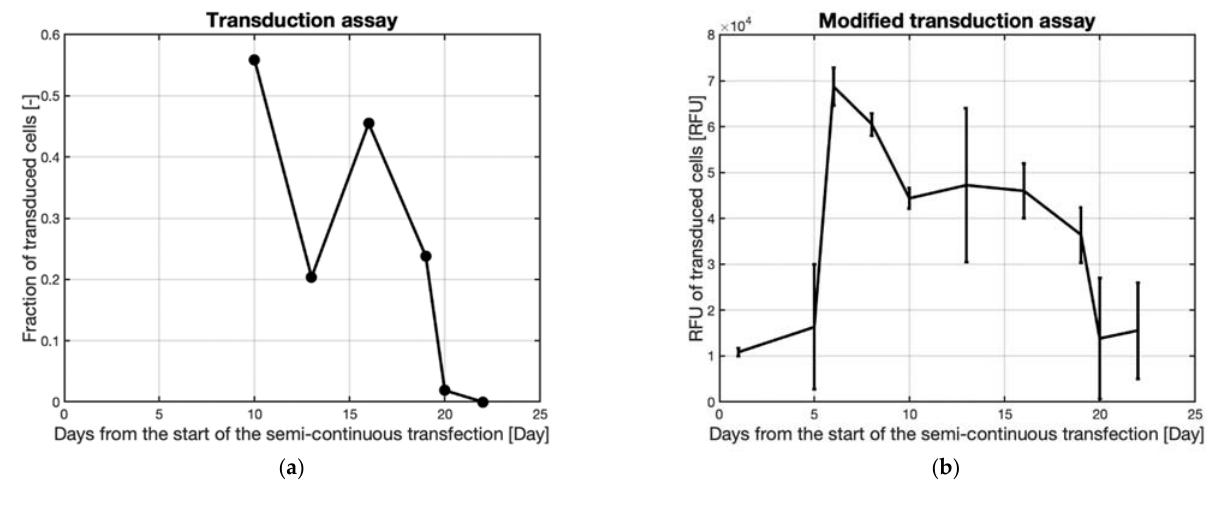
Figure 13. ( a ) Transduction assay results of CHO cells using supernatant samples harvested at various times during the continuous transfection, Figure 12, of HEK293T cells immobilized on Cytodex 1 microcarriers. ( b ) Modified transduction assay results of CHO cells using supernatant samples harvested at various times during the continuous transfection, Figure 12, of HEK293T cells immobilized on Cytodex 1 microcarriers.